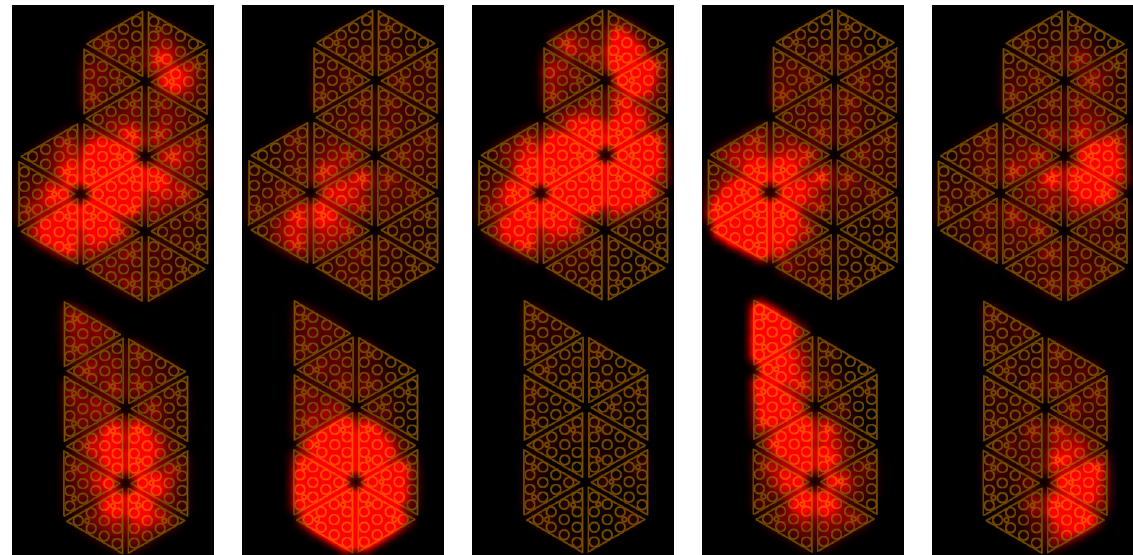
Figure 8. Taxel activation of the left insole in the experiment with sensorised